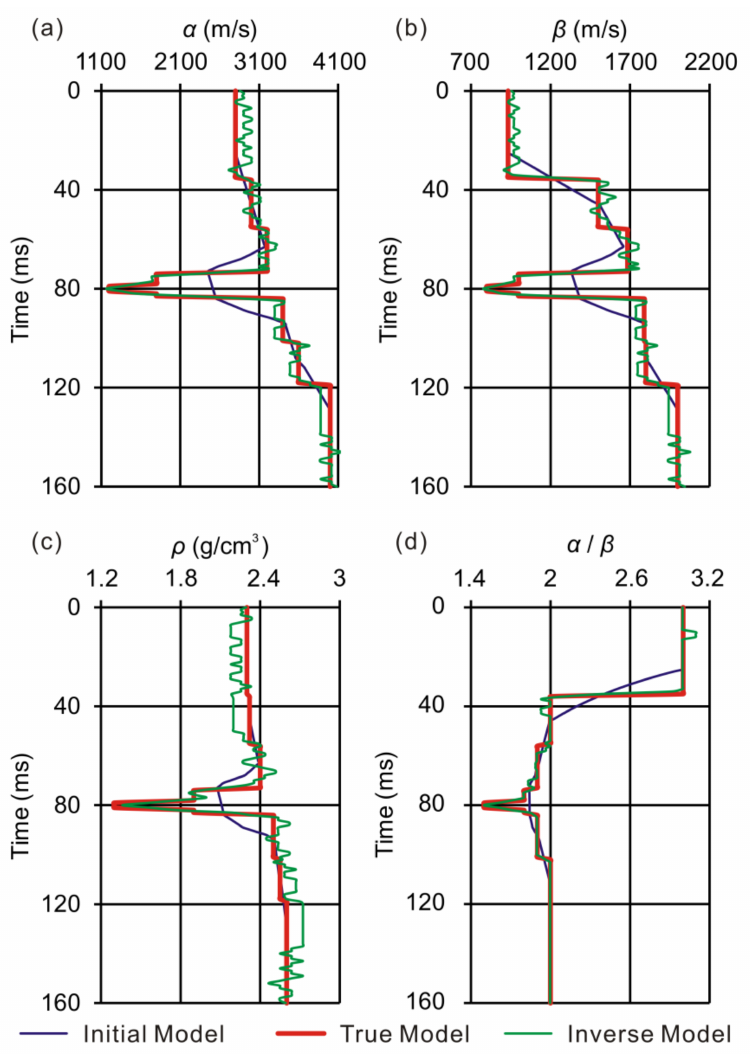
Figure 7. Model-based joint inversion results using the synthetic PP and PS AVA gathers added with 10% random noise: ( a ) P-wave velocity ( α ); ( b ) S-wave velocity ( β ); ( c ) density ( ρ ); and ( d ) P- to S-wave velocity ratio ( α / β